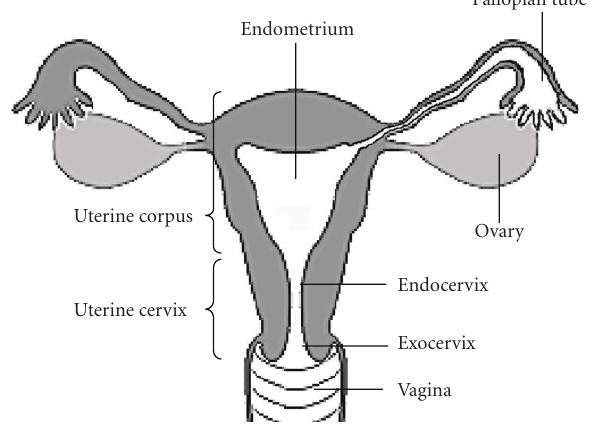
Figure 1: Structure of the female genital